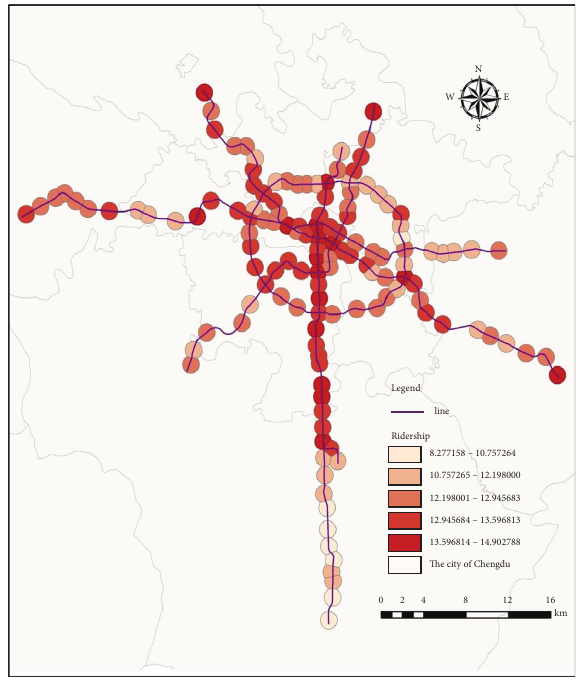
Figure 8: The spatial distribution of the logarithm of ridership in Chengdu